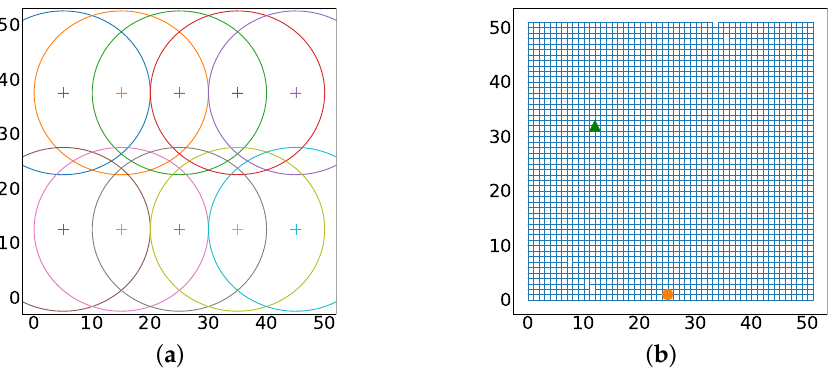
Figure 4. ( a ) Representation of the grid: the vicinity next to an anchor is defined as 15 m from the anchor. ( b ) Simulated patient bounded random